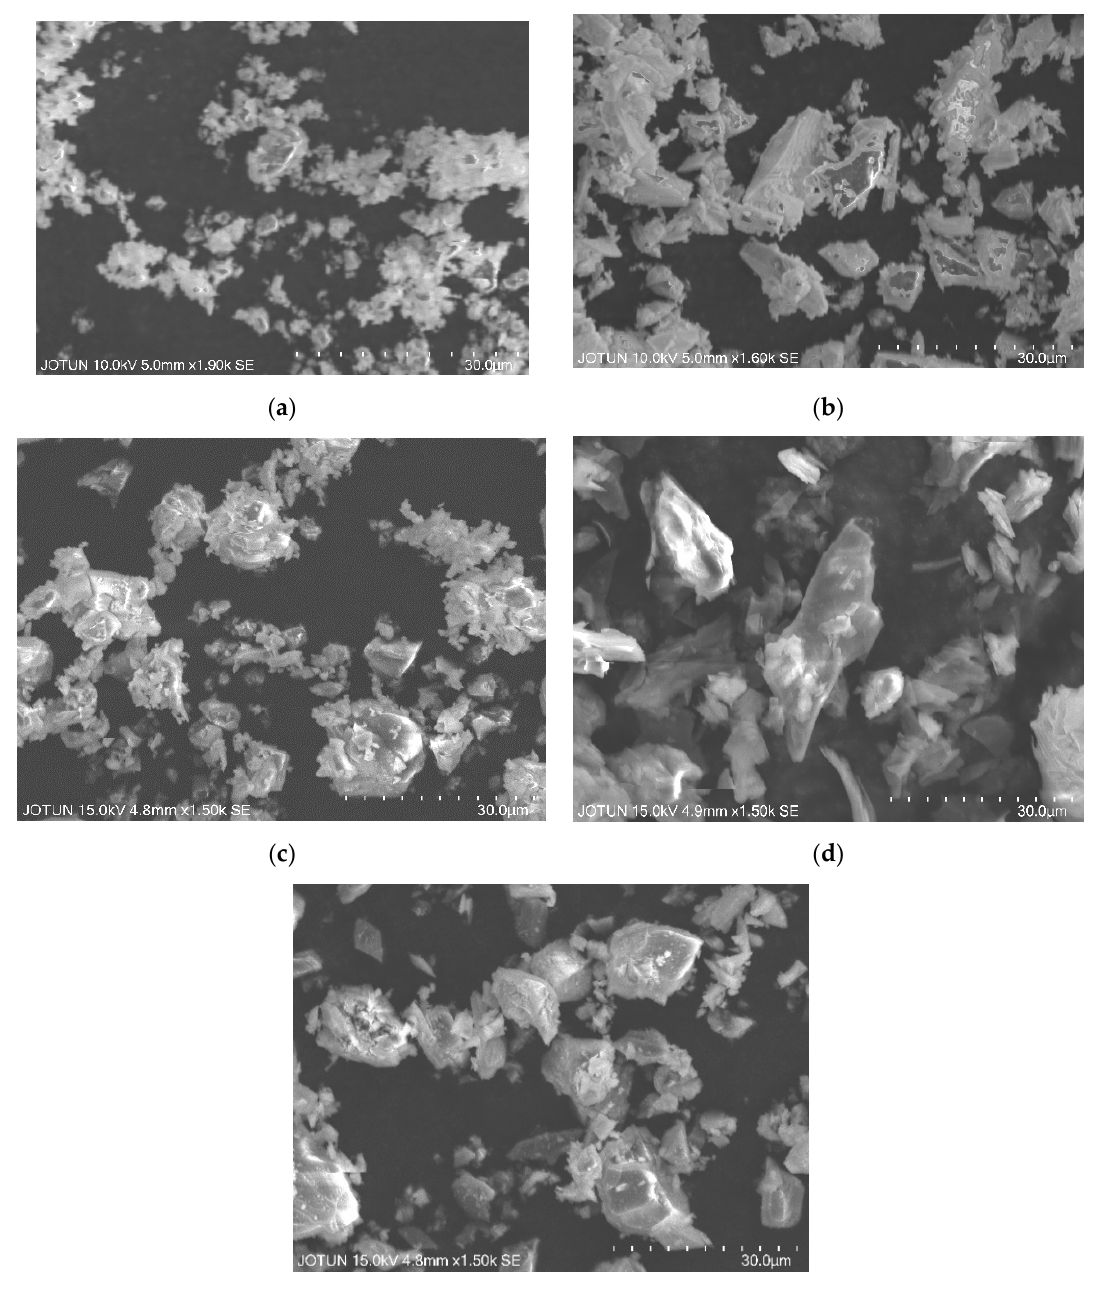
Figure 3. SEM micrographs showing morphology of di ff erent extenders. ( a ) Calcite, ( b ) Feldspar, D 98 = 30 µ m, ( c ) Alumina, ( d ) Talc and ( e ) Feldspar, D